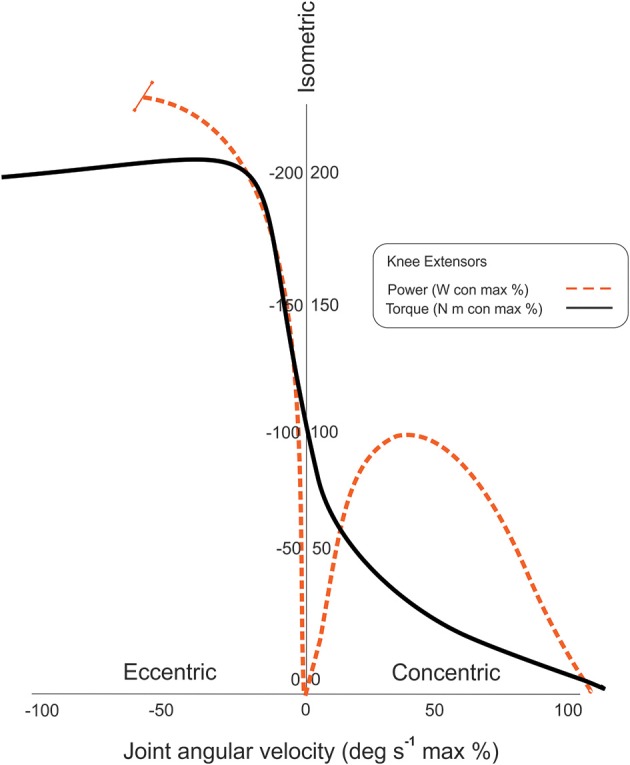
Velocity-dependency of eccentric peak torque and mean power. The power-velocity relationship for eccentric muscle actions differs greatly in comparison with concentric muscle actions as shown in the idealized graph. Peak concentric power is attained at intermediate velocities and peak torque levels, whereas, peak eccentric power rises precipitously with increasing velocities and fairly stable high peak torque levels. (The indeterminate physiologic decline in power at the highest velocities is denoted by the terminal bar on the dashed trajectory line.) (con, concentric; max, maximum).